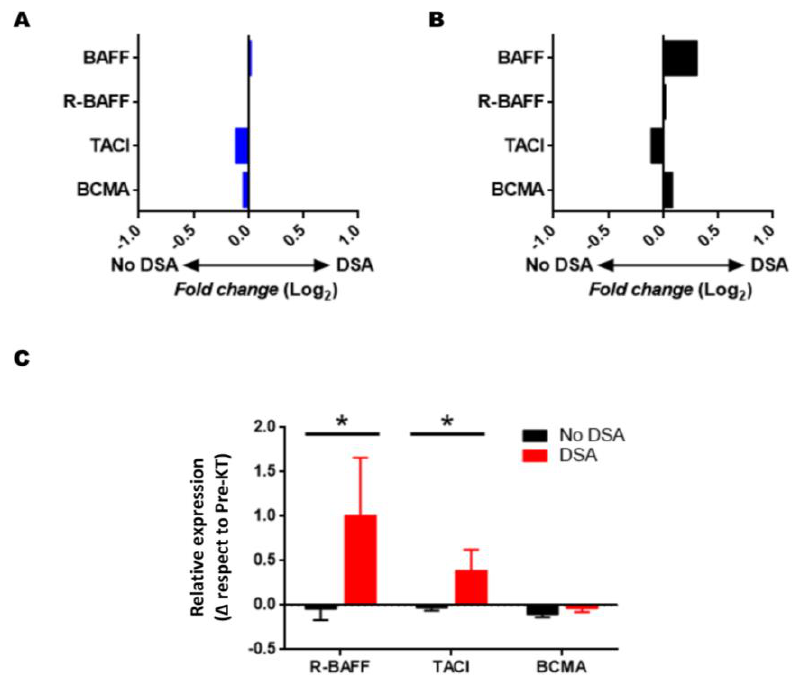
Figure 6. Gene expression of BAFF and its receptors (R-BAFF, TACI, and BCMA) from study GSE50084, and variation of the BAFF gene expression in kidney recipients at three-months post- transplantation. The figure represents the ratio of BAFF, R-BAFF, TACI, and BCMA gene expression in peripheral blood ( A ) and renal biopsy ( B ) in the study GSE50084 among KTRs samples, where positive values indicate an increased expression in transplants with DSA antibodies ’ presence, and negative values indicate an increased expression in KTRs with DSA antibodies ’ absence. p values are adjusted by the FDR method. FDR values < 0.05 were considered significant. ( C ) Variation of the BAFF expression in KTRs at three-months post-transplantation. The figure represents the BAFF system gene expression levels varying between pre- and three-months post-transplantation in KTRs without DSA (No DSA, n = 36) and DSA antibodies ( n = 4) during the follow-up period. Values are represented as the mean ± SEM. Comparisons were made using the Mann – Whitney U test. p values < 0.05 were significant. * p < 0.05.